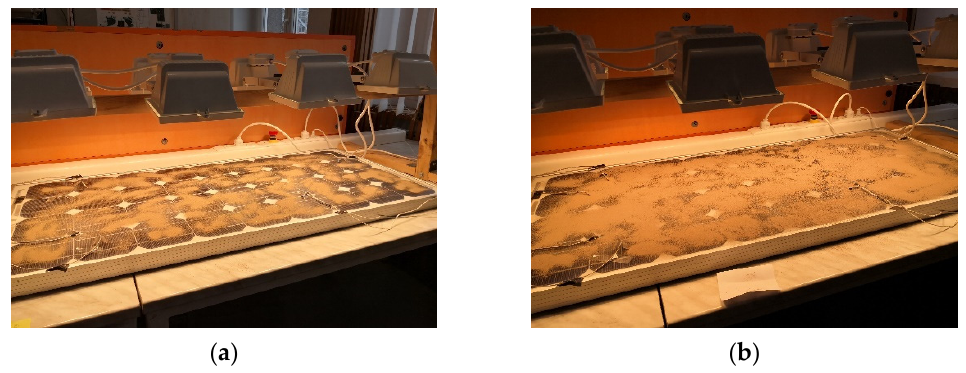
Figure 3. Sand ‐ contaminated solar panel ( a ) and fly ash ‐ contaminated solar panel ( b ). Table 2. Parameters of the investigated solar panel specified by the manufacturer [20].